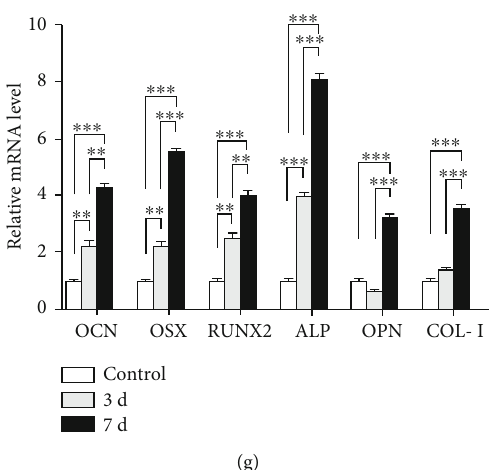
Figure 4: E ff ects of DIM on BMMSC osteogenic di ff erentiation. (a) ALP staining after BMMSCs were treated with 2 mg/mL DIM on the 5th day. Scale bars = 100 μ m . (b) ALP activity after BMMSCs were treated with 2mg/mL DIM on the 3rd and 5th day. ∗∗ P < 0 : 01 and ∗∗∗ P < 0 : 001 . (c) Alizarin red staining showed calcium deposition after 14 days of culture. Scale bars = 200 μ m . (d) Quanti fi cation of (c). ∗∗∗ P < 0 : 001 . (e) Protein expression levels of OCN, OSX, RUNX2, ALP, OPN, and COL-I were determined with western blot. (f) Quanti fi cation of (e). ∗∗ P < 0 : 01 and ∗∗∗ P < 0 : 001 . (g) mRNA expression levels of OCN, OSX, RUNX2, ALP, OPN, and COL-I were determined with qRT-PCR. ∗∗ P < 0 : 01 and ∗∗∗ P < 0 : 001